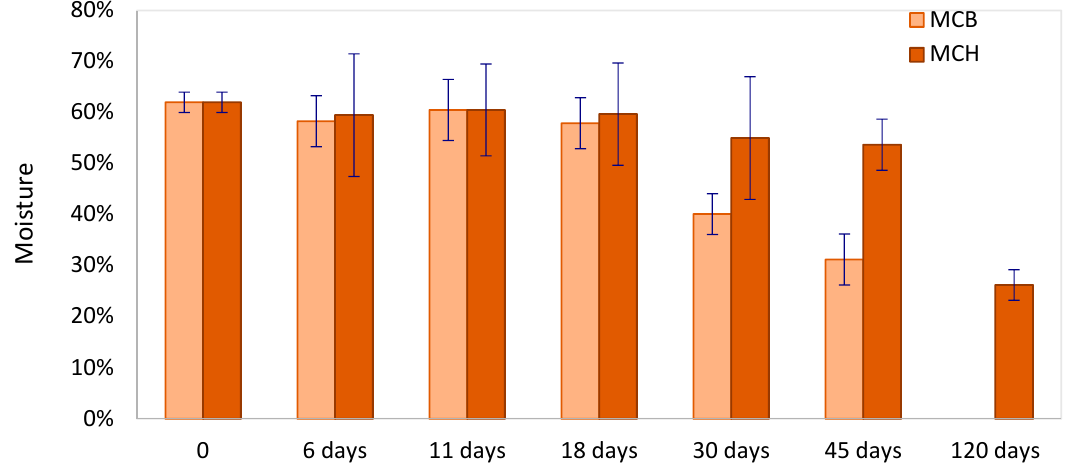
Figure 1. Evolution of the relative humidity of “ Mortadella di Campotosto ”-like sausages produced with beef (MCB) and hog (MCH) casings over time.